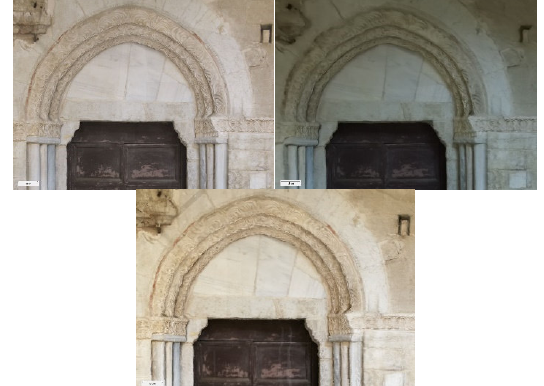
Figure 9. Portions of the orthophotos extracted from the three sensors (left: Compact camera, right: Steadycam, bottom: